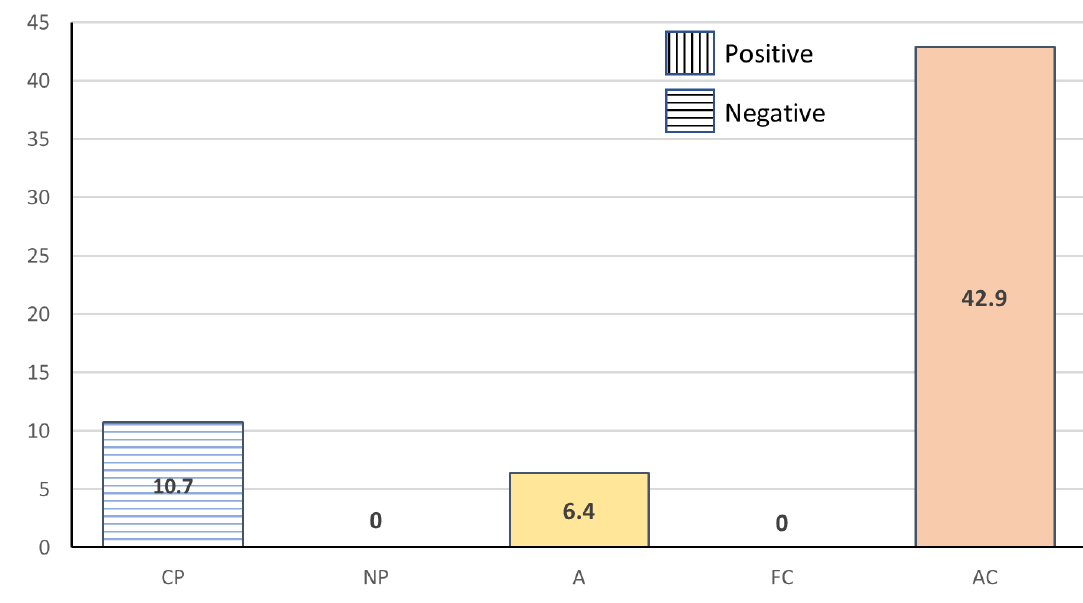
Figure 5: Intoxicated Suicide Egogram